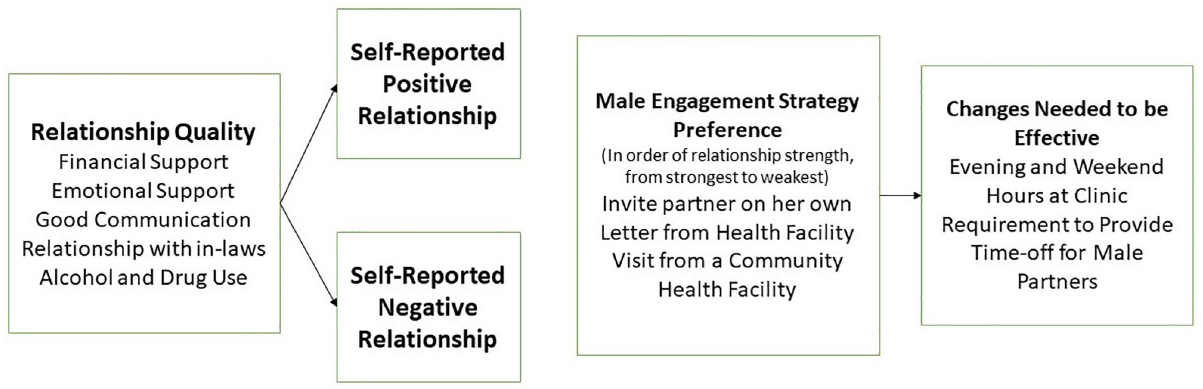
Fig 1. Association of relationship strength to male partner engagement strategy